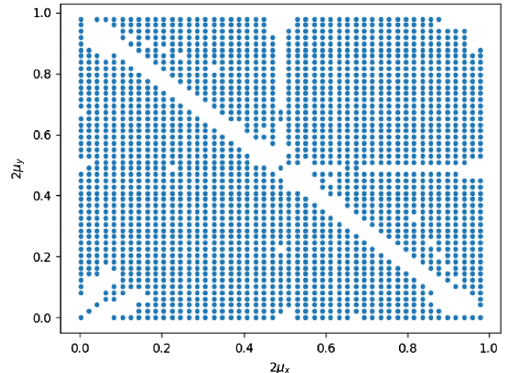
FIG. 12. Stability diagram of M 4 , x 0 ¼ 0 . 5 , y 0 ¼ 0 . 5 , m O ¼ 1 . 0 .